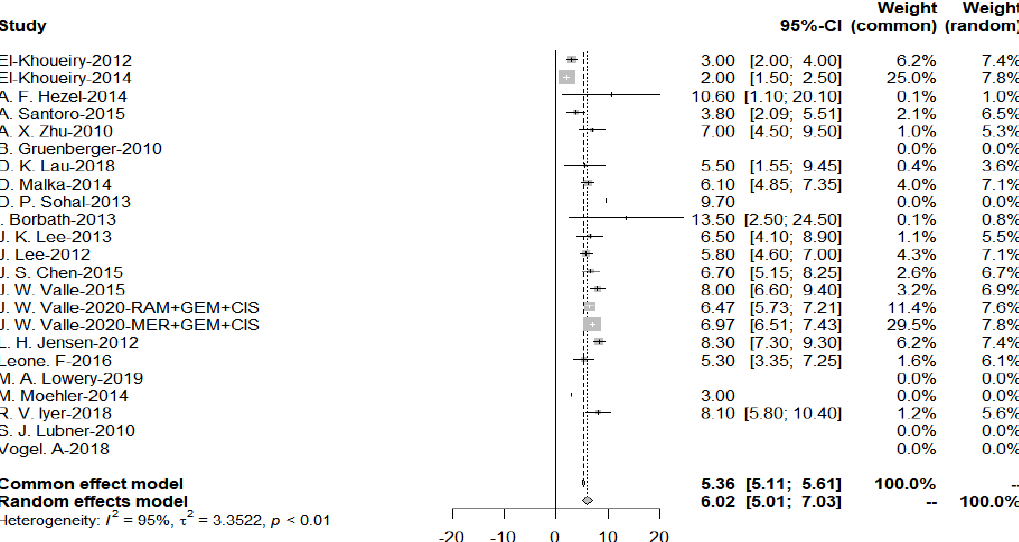
Figure 9. Progression ‐ free survival with targeted therapy.